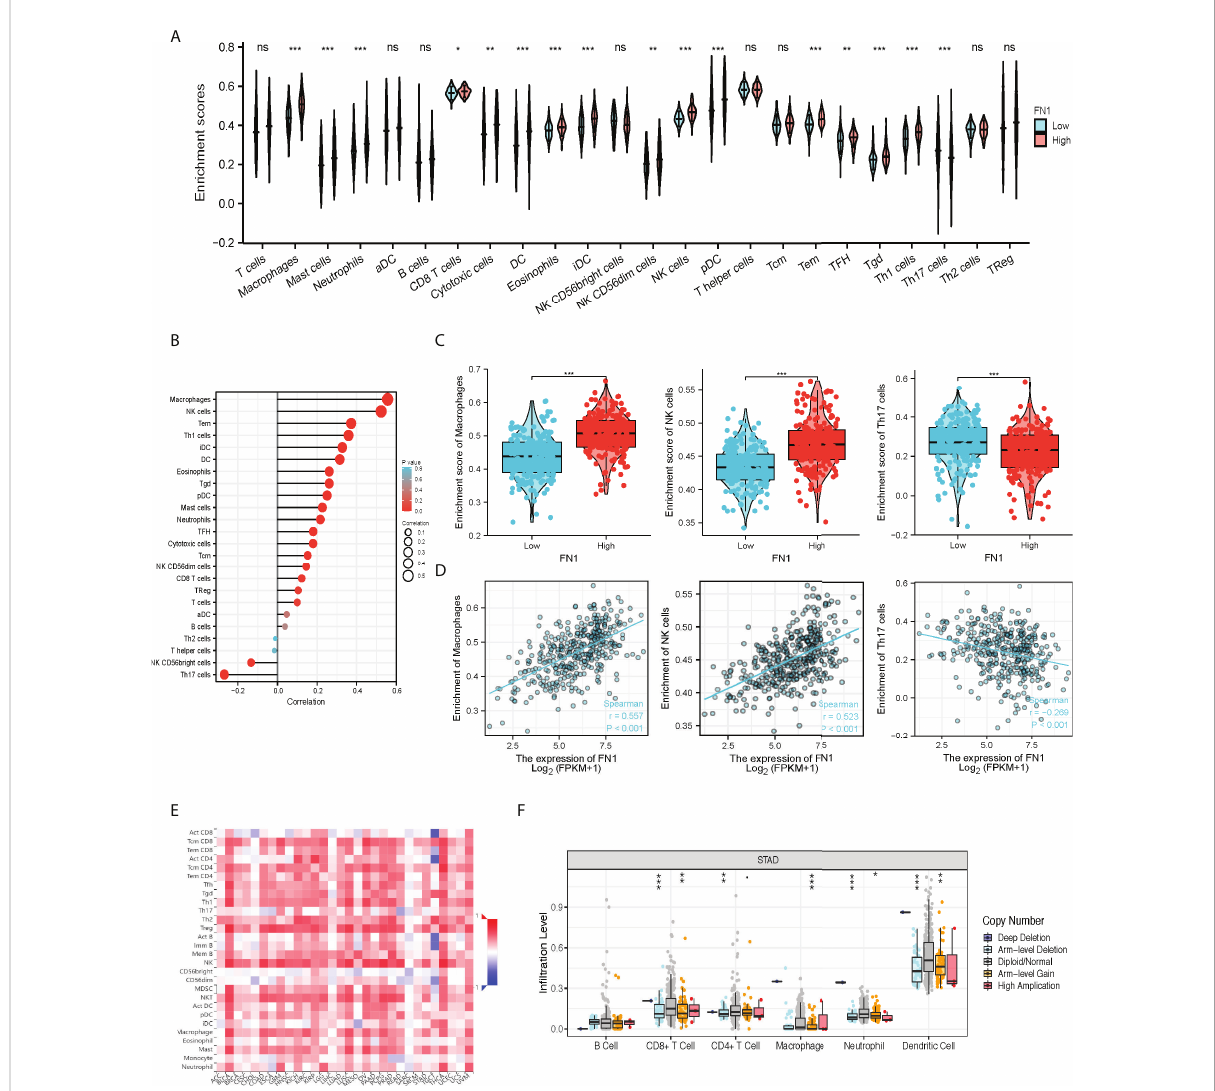
FIGURE 5 The correlation of FN1 expression with immune in fi ltration level in STAD. (A) CIBERSORT was employed to assess the difference of immune cells between FN1 high or low tumors. (B) The correlation between the in fi ltration of immune cells and the expression of FN1. (C, D) FN1 expression signi fi cantly positively correlates with in fi ltrating levels of Macrophage cells and NK cells but negatively correlates with in fi ltrating levels of Th17 cells. (E) Correlation between the expression of FN1 and the abundance of TILs in gastric cancer available at the TISIDB database. (F) Somatic copy number variation (CNV) of FN1 at the level of immune in fi ltration in gastric cancer. *p < 0.05, **p < 0.01, ***p < 0.001, nc p >